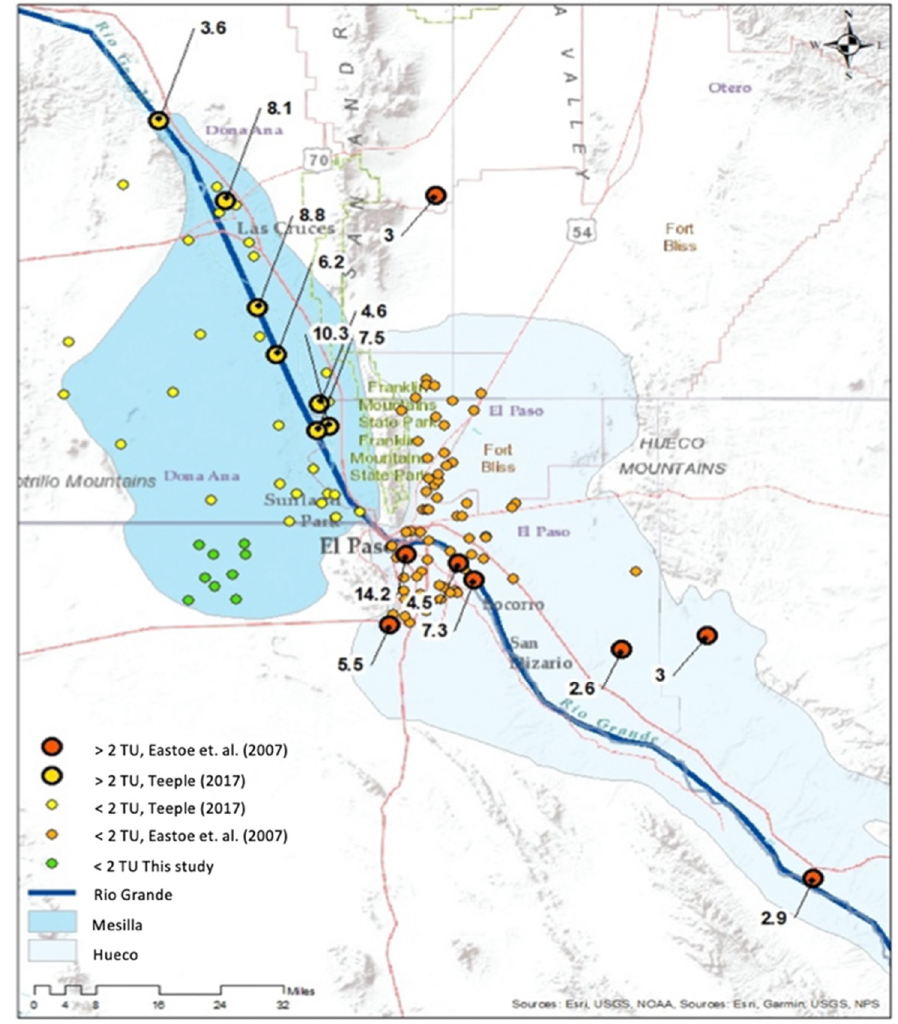
Figure 5. Tritium concentration values of more than 2 TU. The red points with black borders represent values more than 2 TU from Eastoe et al. (2007) [12]. The yellow points with black borders show the values with more than 2 TU from Teeple (2017) [11]. The orange points indicate values lower than 2 TU from Eastoe et al. (2007) [12]. The yellow points indicate values lower than 2 TU from Teeple (2017) [11]. The green points indicate values lower than 2 TU from this study. The Mesilla Basin aquifer is featured in blue, and the Hueco Bolson in light blue. The line in dark blue shows the Rio Grande mainstream.